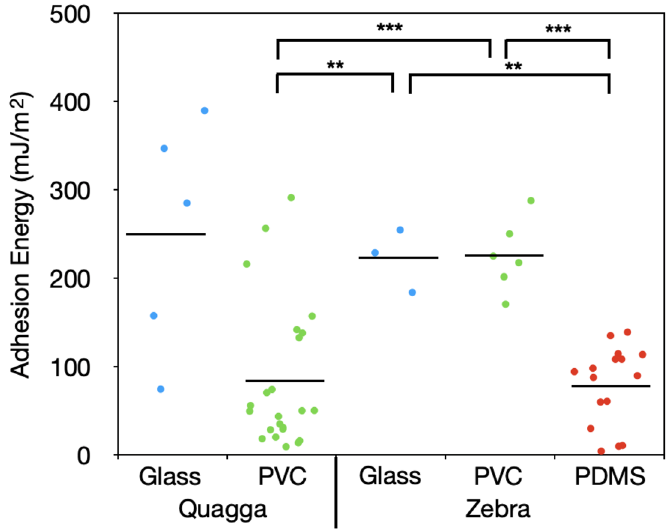
Figure 6. The adhesion energy of quagga and zebra mussels on glass, PVC, and PDMS. Zebra mussel adhesion energy on PVC was statistically different to that on PDMS and to that for quagga mussels on PVC, while quagga mussels on PVC was significantly different from zebra mussels on glass as well. Additionally, zebra mussels on glass and on PMDS were statistically significant. All other combinations showed no statistical differences. ** denotes p ≤ 0.01, *** denotes p ≤ 0.001.